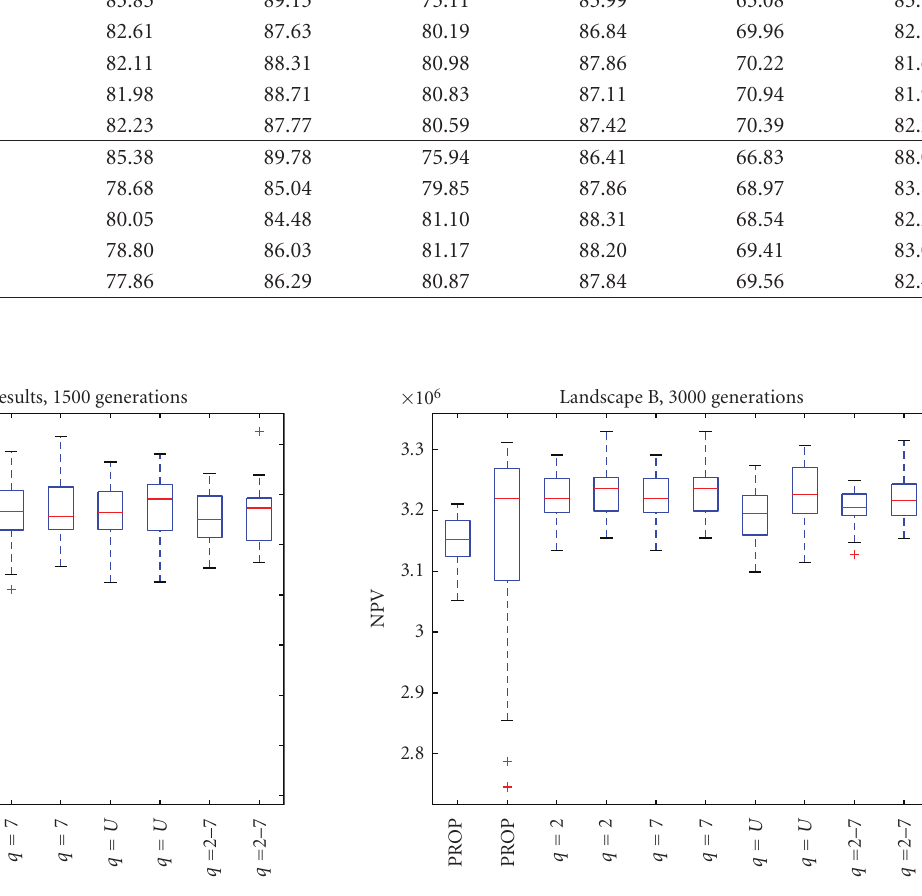
Figure 4: Results for Landscape B, 3000 generations. This figure presents a box-plot of solution quality (NPV; y -axis) for each paired selection/penalty strategy tested. The x -axis displays the strategy; static and dynamic penalty strategies for the same selection strategy are displayed side by side (static on the left side). Reading from left to right, the first selection strategy presented is proportional selection and the rest are deterministic tournaments with various competitor pool sizes ( q ). The label “ q = U ” corresponds to the strategy wherein q was sampled from a uniform distribution over the range (2, 10), and the label “ q = 2–7” corresponds to the strategy where q increased from 2 to 7 during the search.